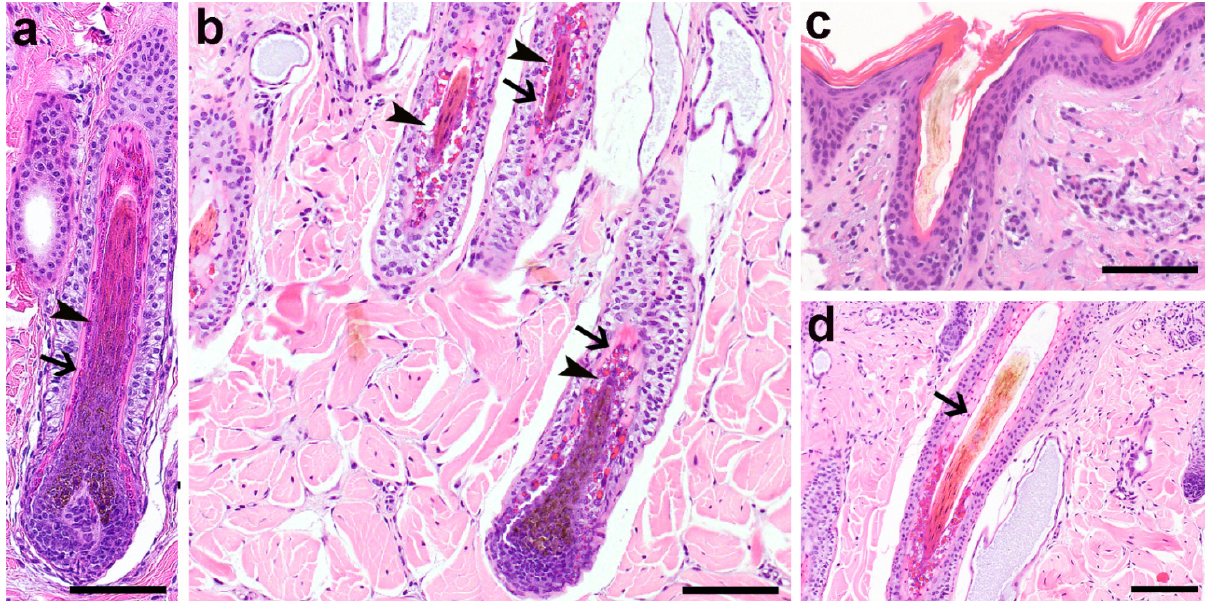
Figure 2. Histological changes displayed by a Hereford calf with congenital hypotrichosis. ( a ) Proximal portion of an anagen HF of a 1,5-month-old Simmental calf with a normal, non-cornified Huxley layer (arrowheads) and an already cornified Henle layer of the IRS (arrows) for comparison purposes. H&E staining, 200×. ( b ) Proximal portion of the anagen hair follicles of an affected Hereford calf (case 1) with a severely altered morphology of the inner root sheath. The cells of the non-cornified Huxley layer present with large, irregular sized trichohyalin granules and large vacuoles (arrowheads) in the cytoplasm. The already cornified Henle`s layer (arrows) presents with large corneocytes with irregular staining characteristics. H&E staining, 200×. ( c ) Infundibulum with a dysplastic hair shaft from case 1, characterized by an irregular outer contour. H&E staining, 200×. ( d ) Altered cornification of the IRS in the isthmus region in case 1. The cornified IRS appears wider than normal and displays irregular staining characteristics. Nuclei were not arranged orderly (arrow) and the hair shaft has an irregular contour. H&E staining, 200×, bar 100 µm in ( a , b , d ); bar 50 µm in ( c ).